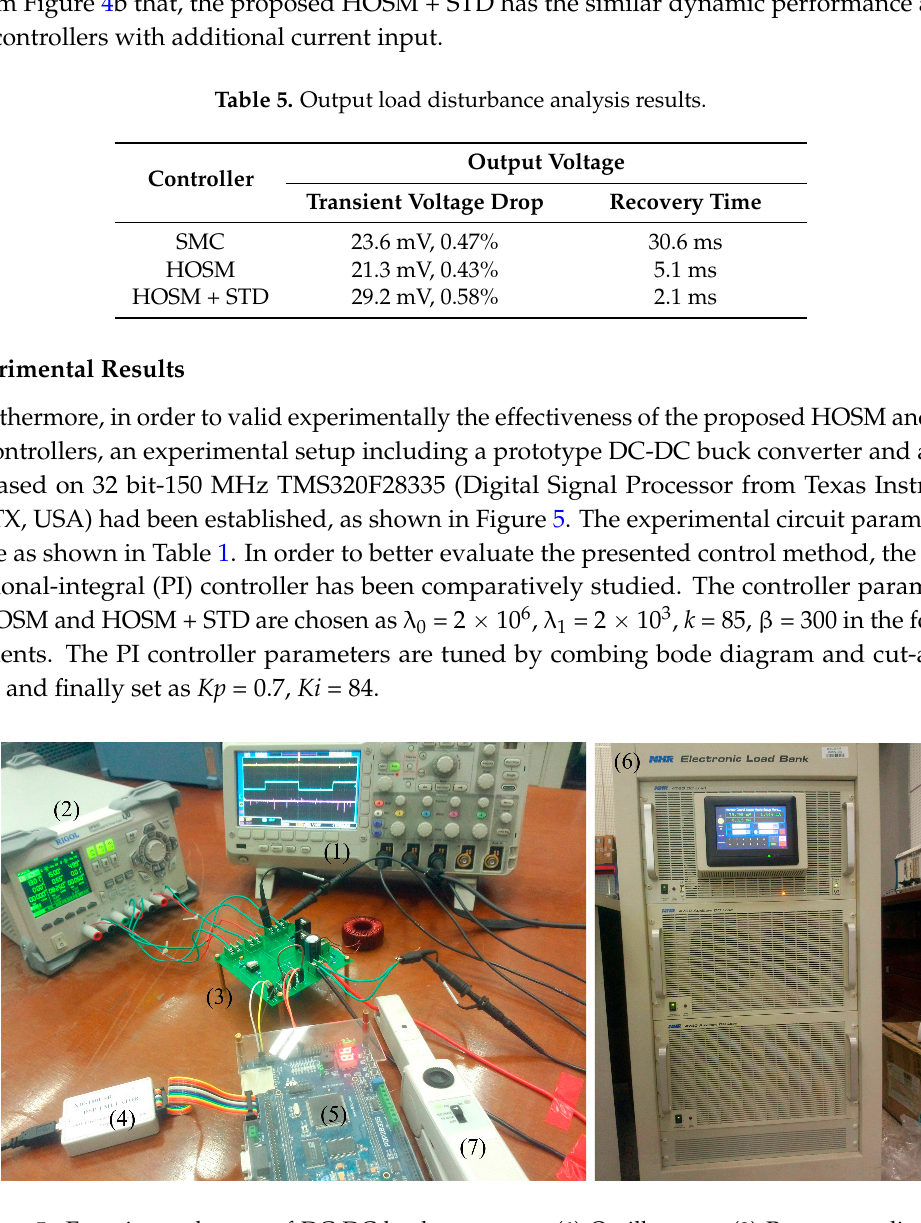
( b ) Figure 6. Experimental results of average output voltage ( a ) for different input voltage ( R = 2.5 Ω ); ( b ) for different load resistance ( V in = 15 V). 8